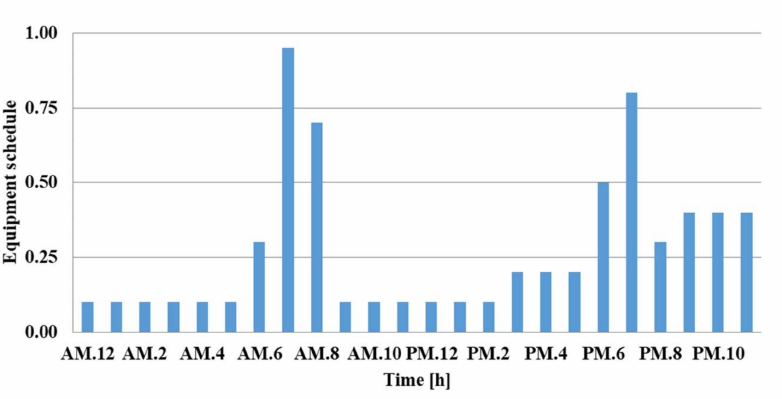
Figure 15. Equipment schedule from Statistics Korea’s